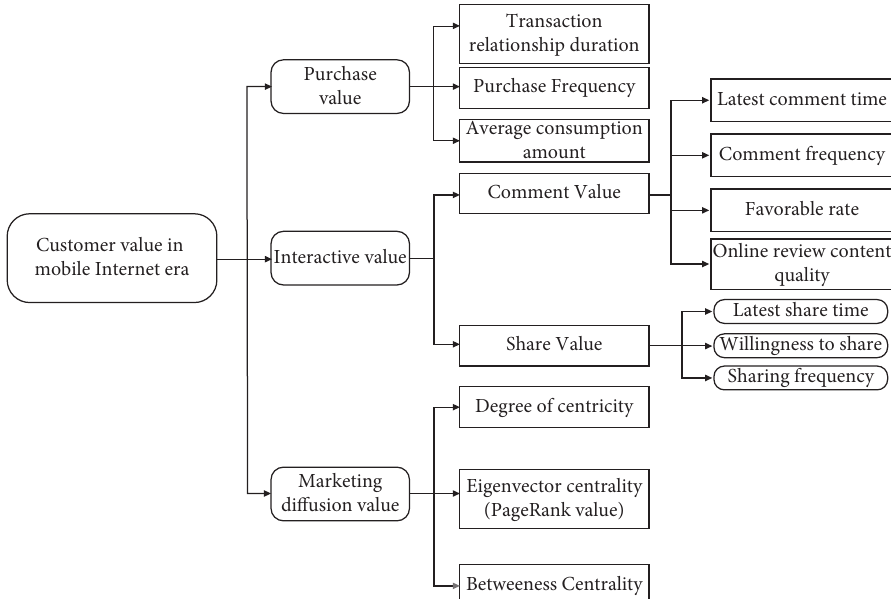
Figure 7: Integrated model of the customer value in the mobile Internet era. Table 2: The description of variables in the mathematical